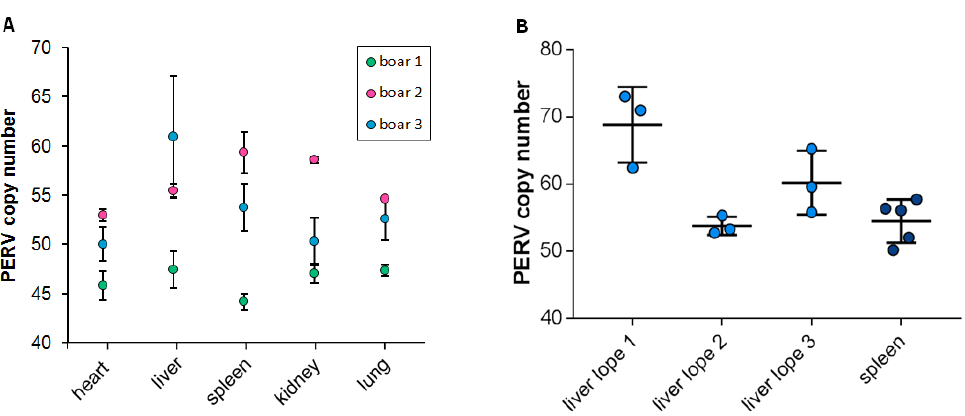
Figure 3. Number of integrated PERV proviruses ( A ) in different organs from three recently hunted wild boars in Brandenburg and ( B ) in three different regions of the liver and in five regions of the spleen of wild boar 3.